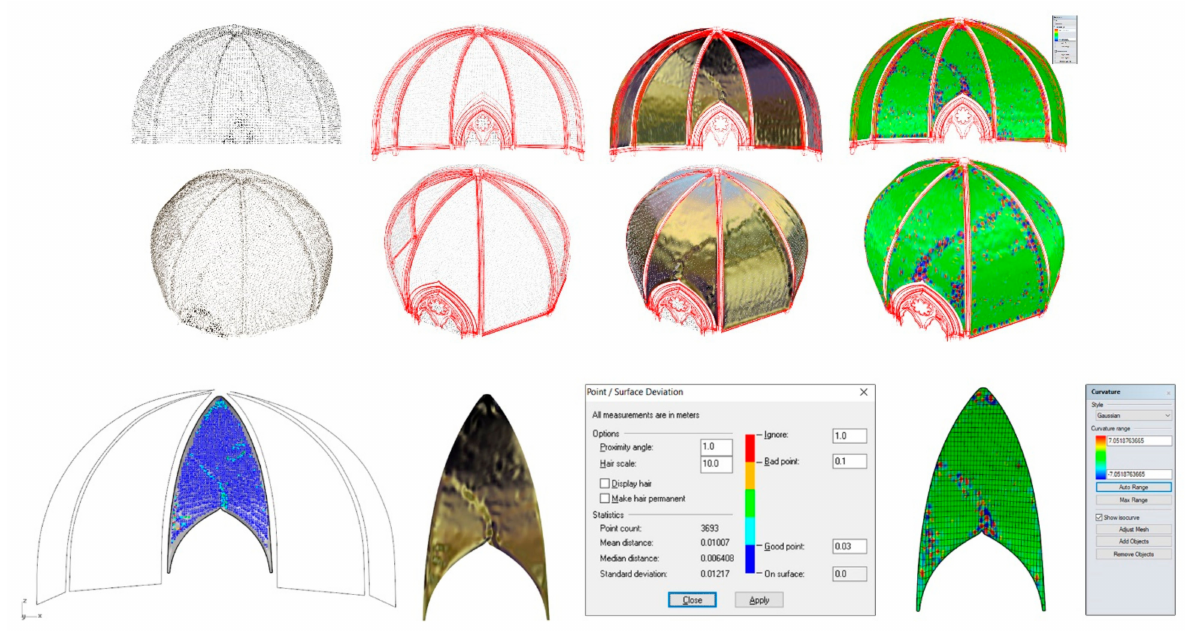
Figure 10. Grade of accuracy of HBIM model of Basilica of Collemaggio allowed users to share the reliability of each element during the process and define an automatic verification system (AVS) to compute the GOA of case studies and related complex